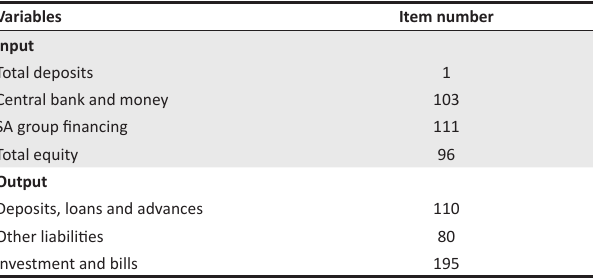
TABLE 4: Selected input and output variables for estimating technical and scale efficiency. Variables